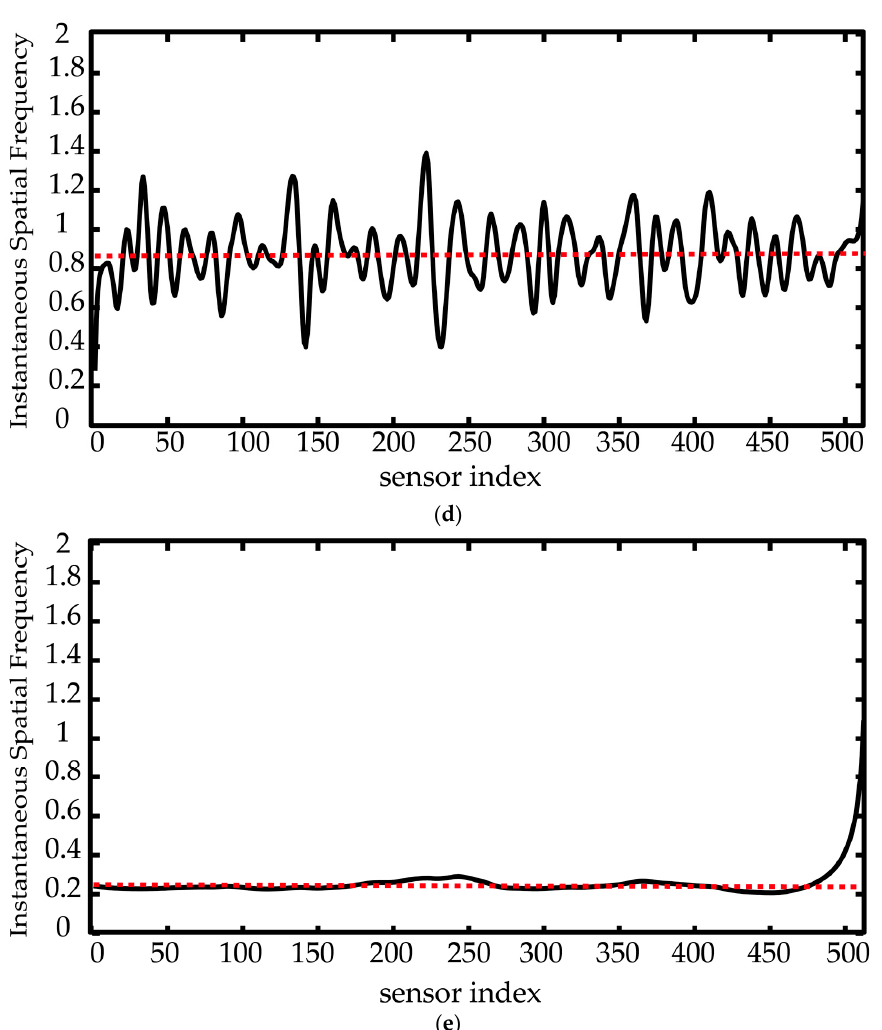
Figure 2. ( a ) The snapshot data; ( b ) The first IMF at the direction angle of 56 ◦ ; ( c ) The second IMF at the direction angle of 10 ◦ ; ( d ) Spatial IF (black) with linear regression line (red) at the angle of 56 ◦ ; ( e ) Spatial IF (black) with linear regression line (red) at the angle of 10 ◦